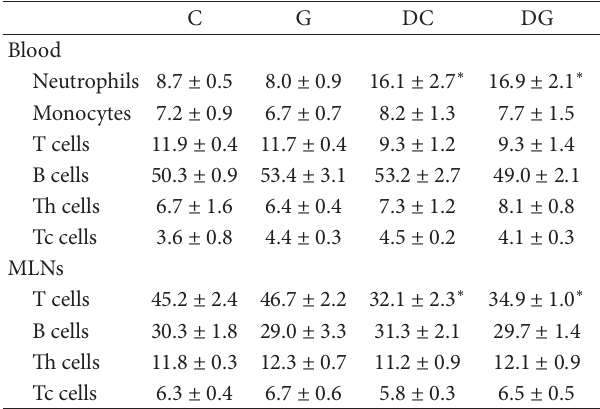
ulations, lymphocytes were gated on the basis of their forward-and side- scatter profiles. Percentages of T helper (Th) and cytotoxic T (Tc) cells were respectively determined by CD4-and CD8-expressing cells in lymphocytes. Values are presented as the mean ± SEM. ∗ Significantly differs from the C group ( 𝑃 < 0.05